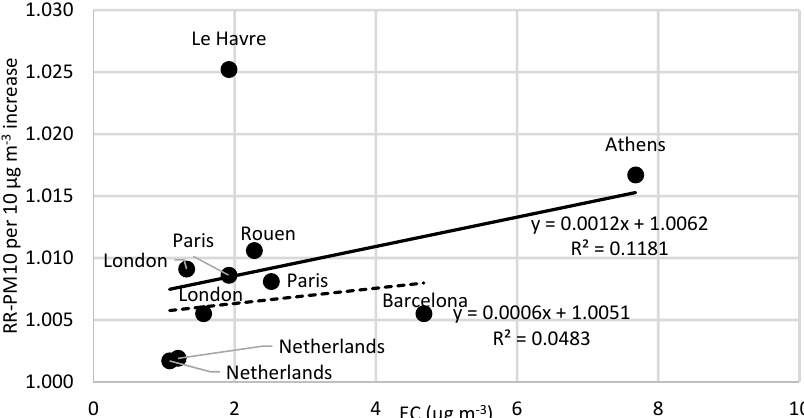
Figure 5. The relative risks of cardiovascular mortality associated with short-term exposure to PM 10 as a function of the levels of elemental carbon (EC). With a 95% CI, the slope value of the solid line is not statistically significant. The dashed line represents the relationship where Athens and Le Havre are excluded. The EC concentrations are based on BS values transformed by using the calculated mean of 12% EC content in BS.